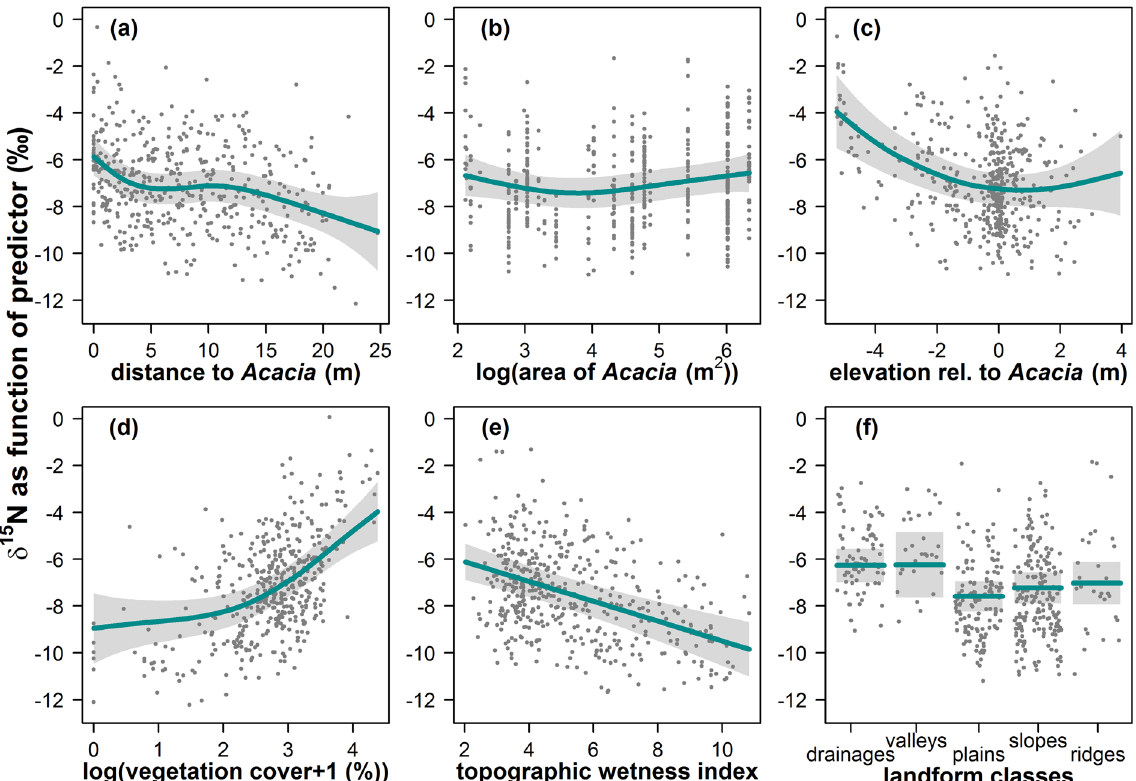
Figure 3. ( a–e ) Smoothing functions used by the generalized additive mixed model. Smoothers describe δ 15 N as a function of the respective predictor (lines) along with their 95% confidence intervals (grey shading) and partial residuals (points), which are the residuals for each predictor when all other predictors are held constant at their mean (continuous predictors) or at the most frequent class (for factors). ( f ) Effect of the categorical predictor landform